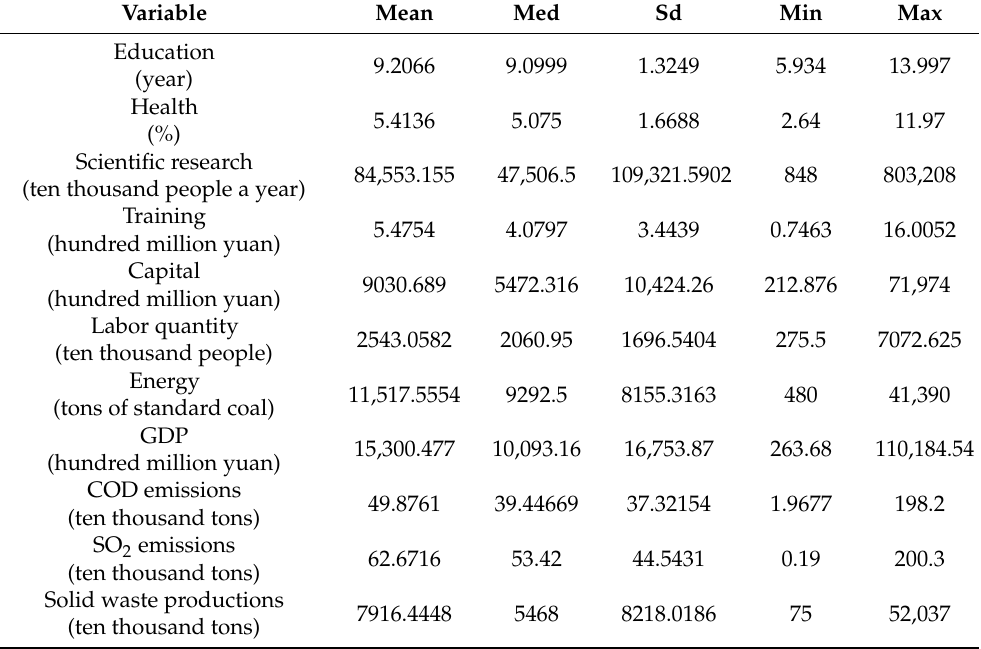
Table 3. Descriptive statistics for